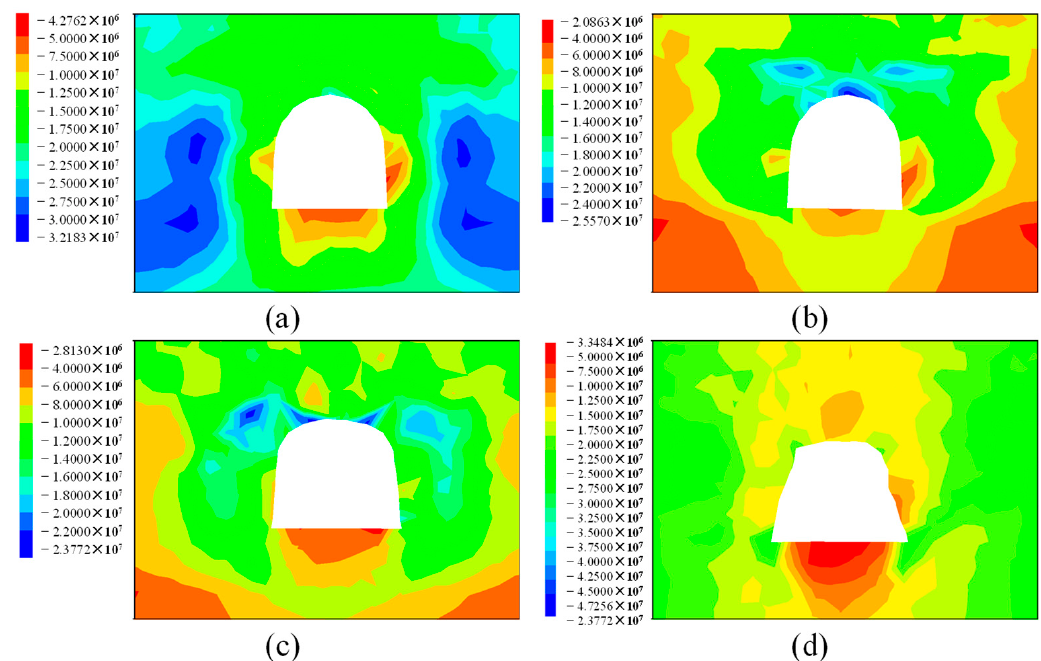
Figure 7. The distribution of horizontal stress in the roadway: ( a ) Case 1; ( b ) Case 2; ( c ) Case 3; ( d ) Case 4.